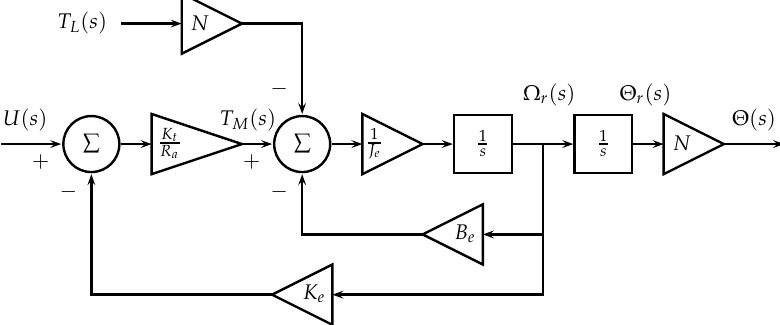
Figure 4. Block diagram of the electromechanical system considering L a